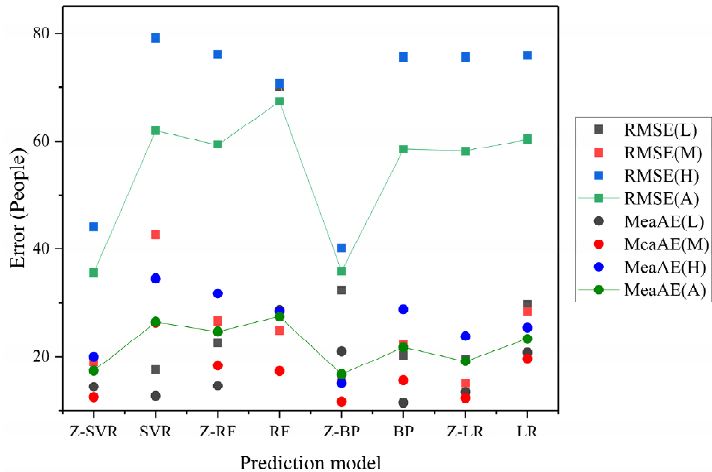
Figure 15. Regression performances of Z-SVR and other